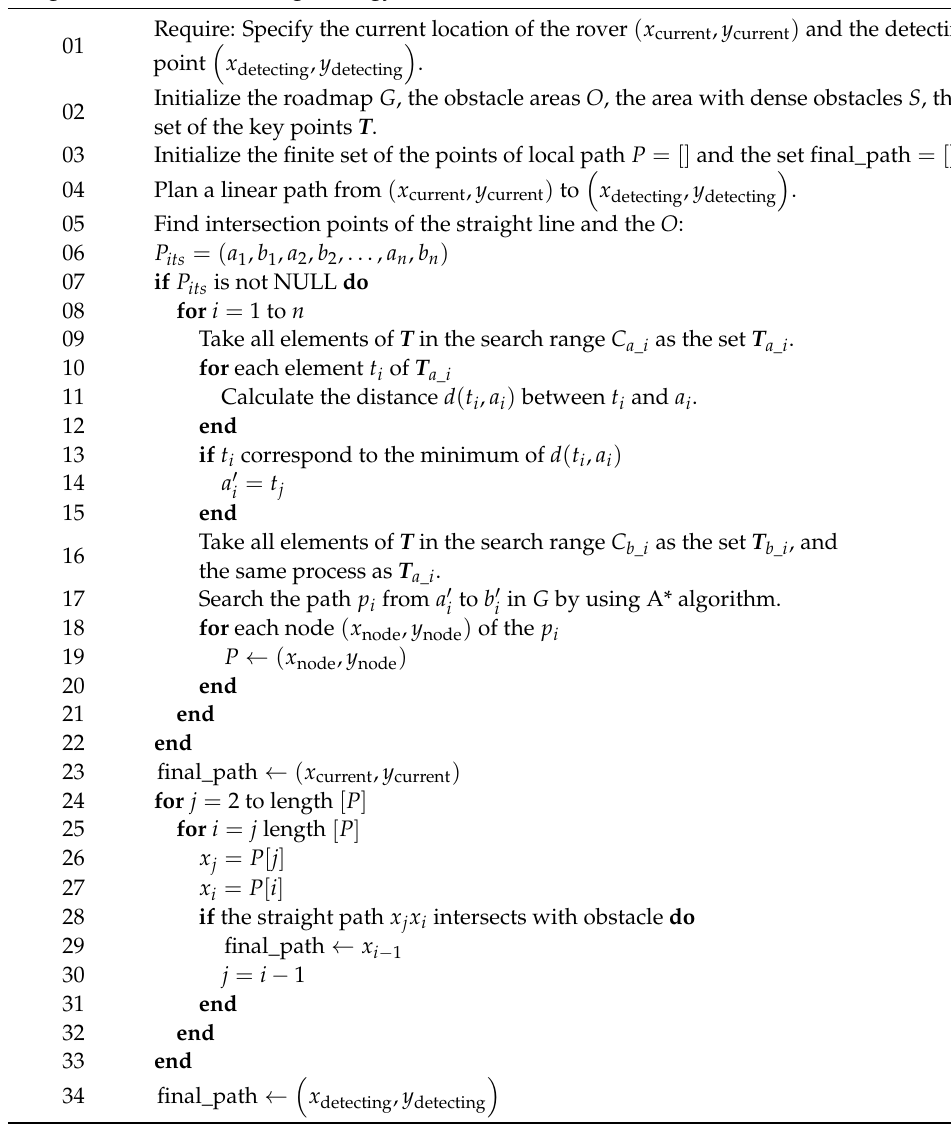
Algorithm 2: Path Planning Strategy under Linear